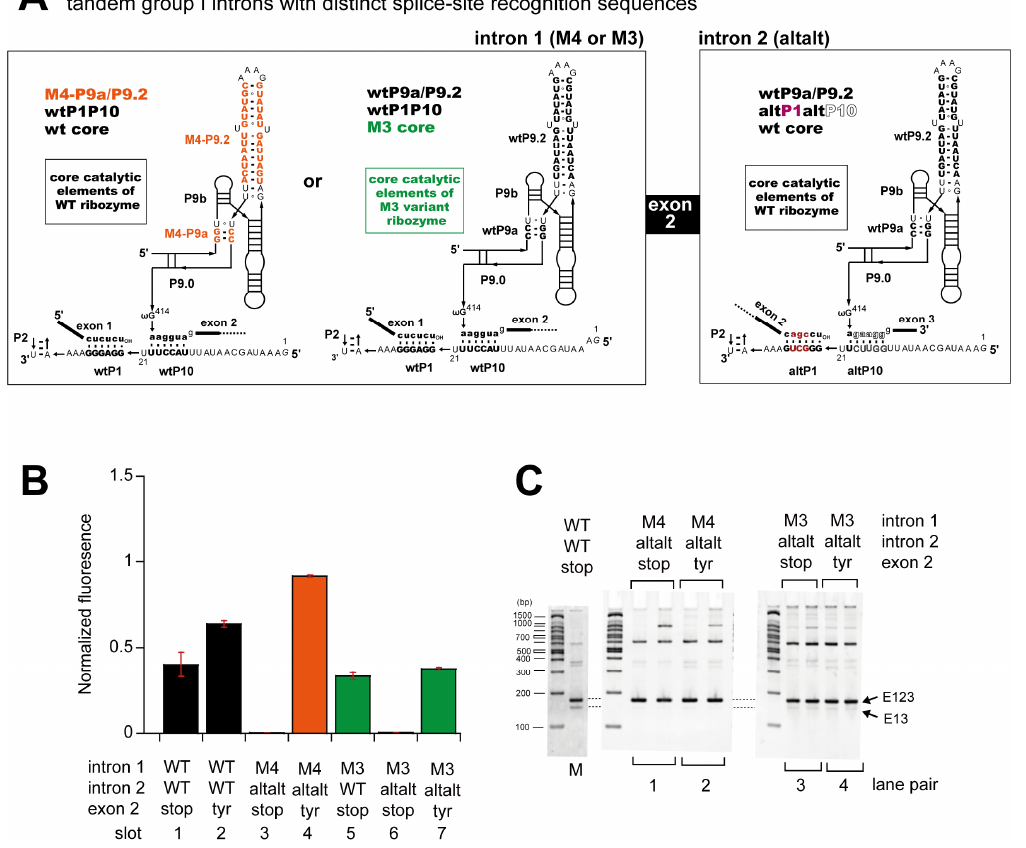
Figure 8. Suppression of exon-skipping splicing in tandemly aligned introns with distinct splice site recognition sequences. ( A ) P9a/9.2, P1, and P10 elements in tandem introns with distinct splice site recognition sequences. ( B ) β-Galactosidase reporter gene assays to evaluate the splicing activities of precursors with two introns and a short exon (exon 2) in E. coli . ( C ) RT-PCR assays to distinguish the ligated exons (E123 or E13) including or skipping exon 2, with lengths of 174 and 150 bp,